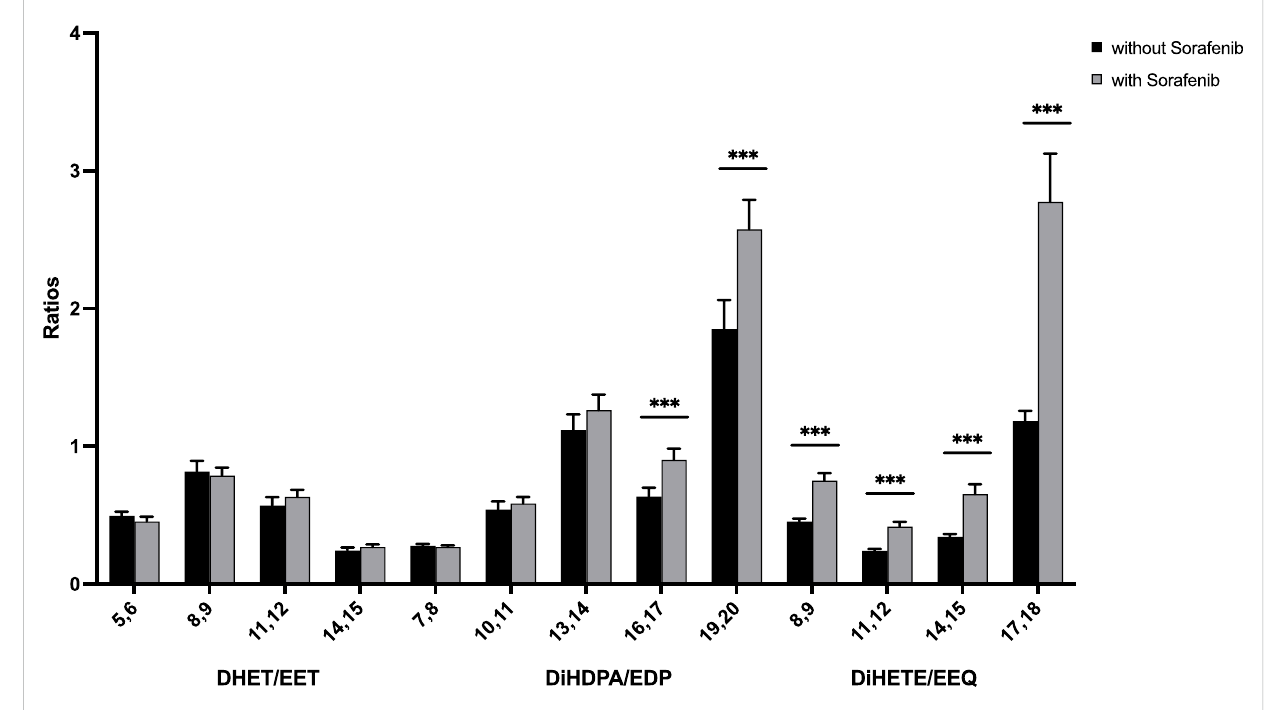
FIGURE 4 Ratio of n-6 and n-3 PUFA-derived dihydroxy to epoxy-PUFA as a marker for sEH activity in n = 43 patients with HCC without and undergoing sorafenib treatment (*** p < 0.001).